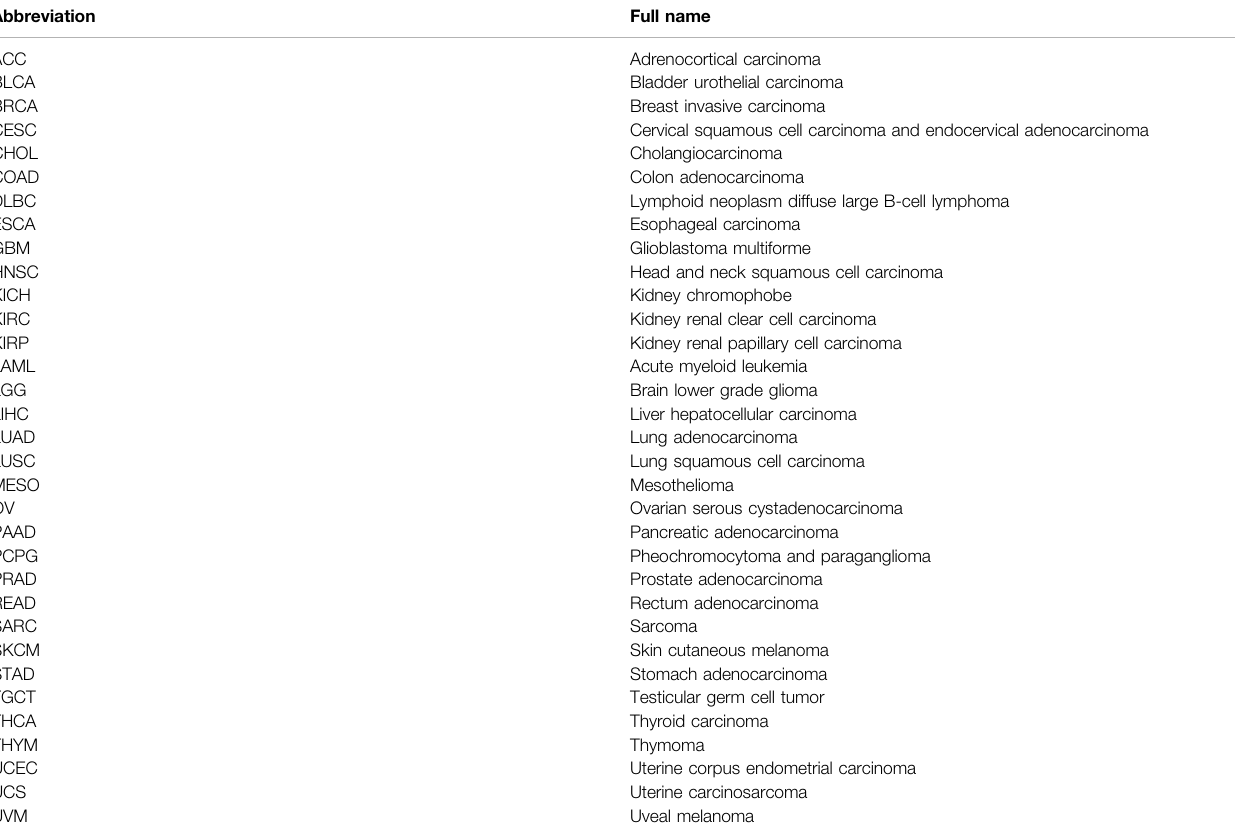
TABLE 1 | Cancer types from TCGA